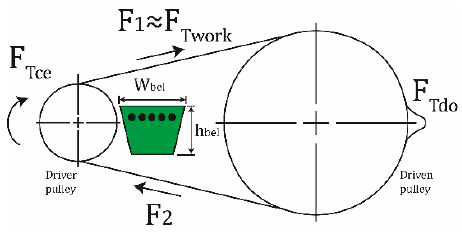
Figure 2. Working tensions in the rubber V-belt.